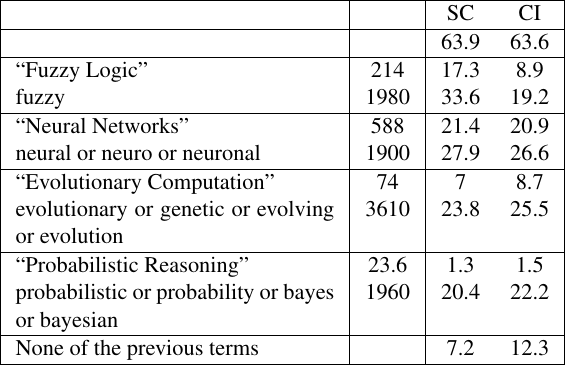
Table 3. Entries in Scholar (in thousands) containing terms re- lated to SC and CI.